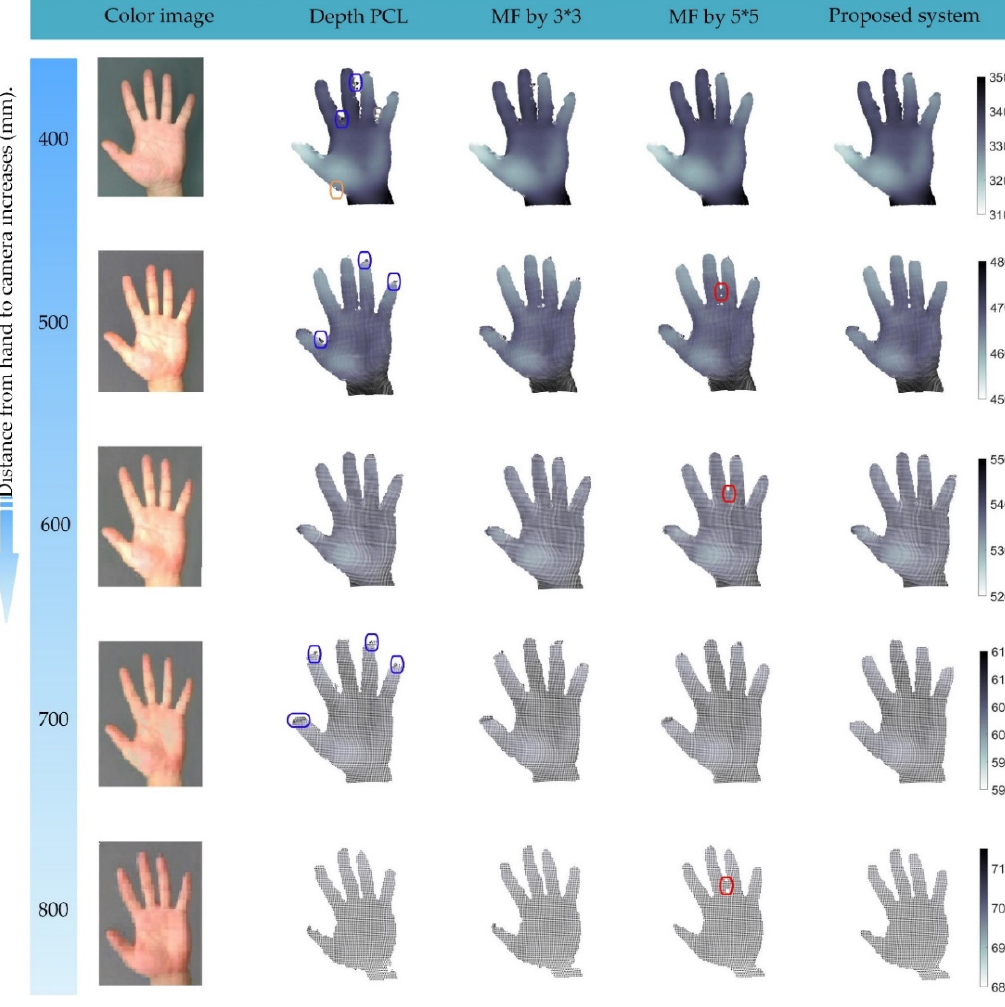
Figure 9. Comparisons at different distances by using SR300.